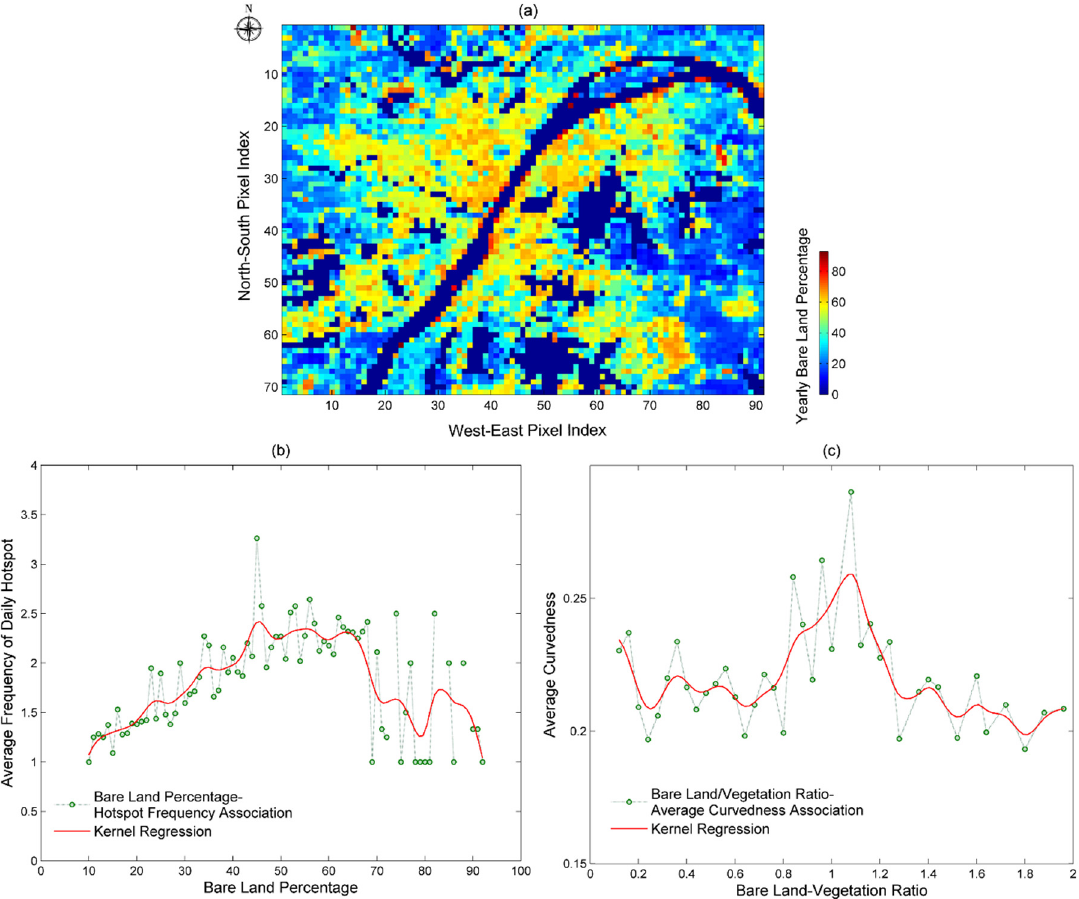
Figure 11. The hotspot dynamics–land surface composition relationship. ( a ) The yearly bare land percentage; ( b ) The yearly bare land percentage– hotspots frequency association. The frequencies are averaged in each 1-percent-interval of bare land to highlight the trend; ( c ) The impacts of bare land-vegetation cover ratio on the hotspots curvedness. The curvedness are averaged in each 0.04 of the ratio interval to highlight the trend.